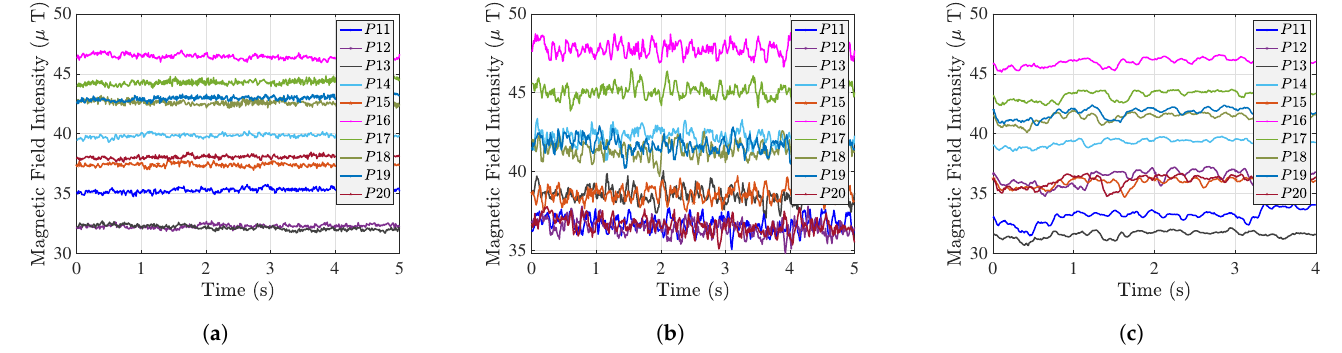
Figure 15. Smartphone training set in zone 2. ( a ) iPhone Xs Max. ( b ) Huawei P9. ( c )